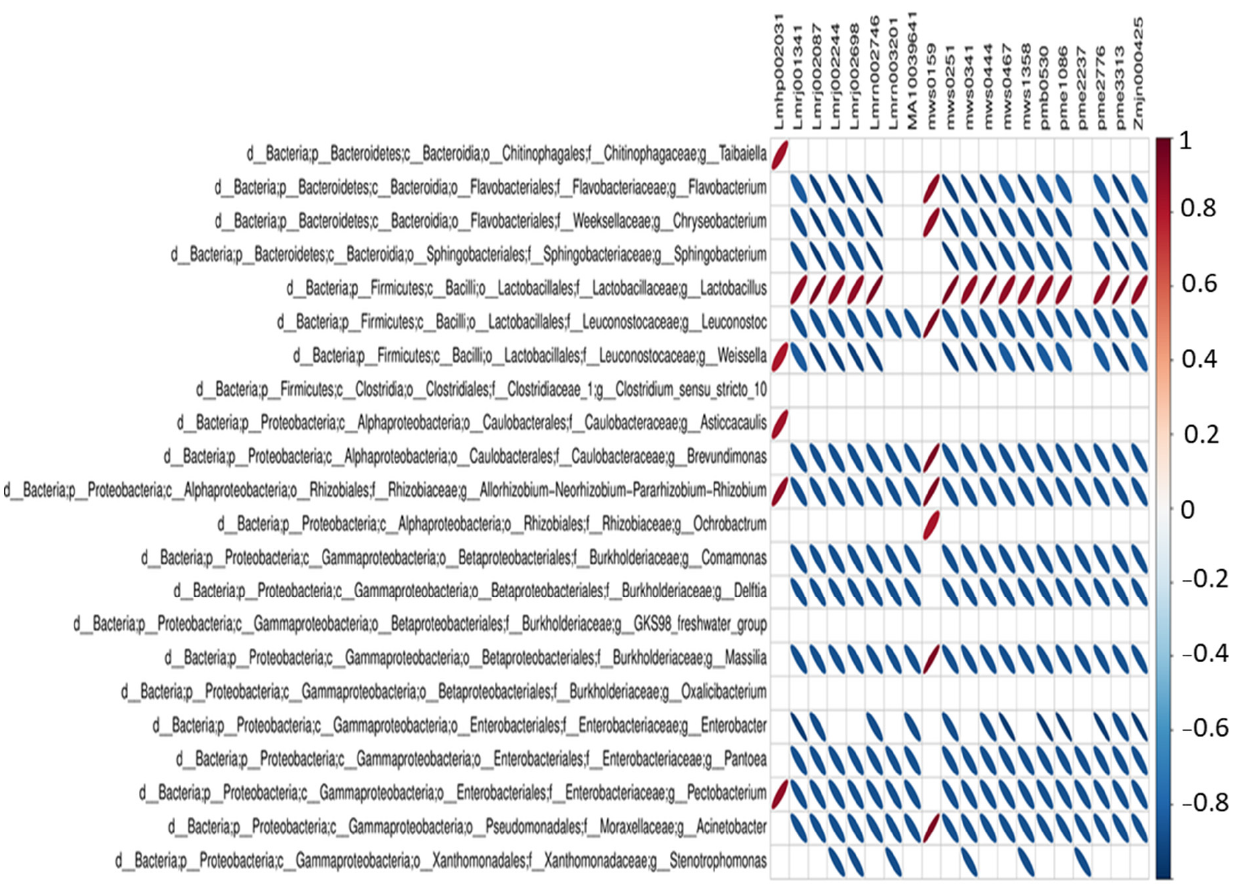
Figure 9. Heat map showing the Spearman correlation of the top 20 differential metabolites and dominant bacterial genera (A red ellipse indicates positive correlation, while blue ellipse represents a negative correlation. The higher the absolute value of the correlation, the thinner the ellipse. A blank grid indicates that the significance p value is greater than 0.05).